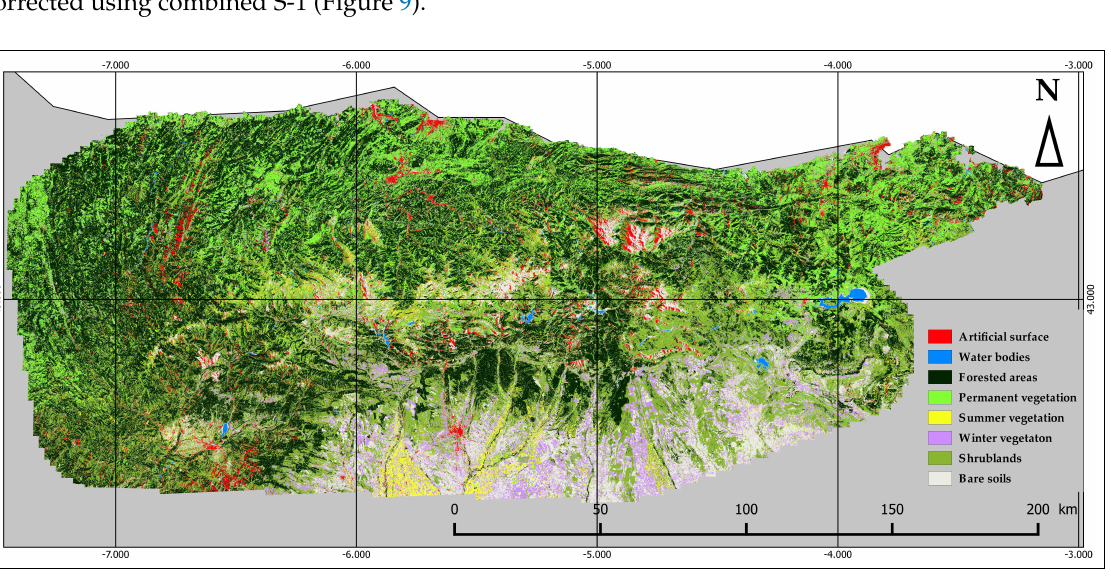
Figure 9. Classification of the Spanish study area using combined Sentinel-1 & 2